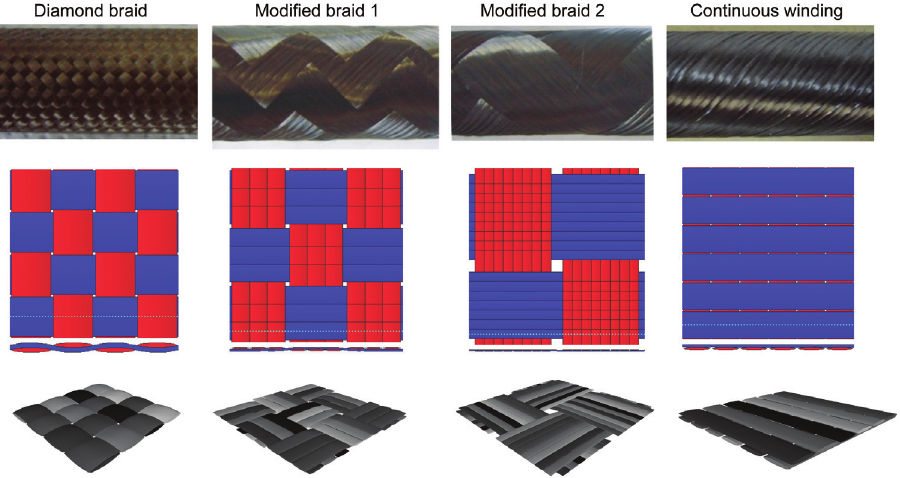
Figure 13 Different investigated braid pattern